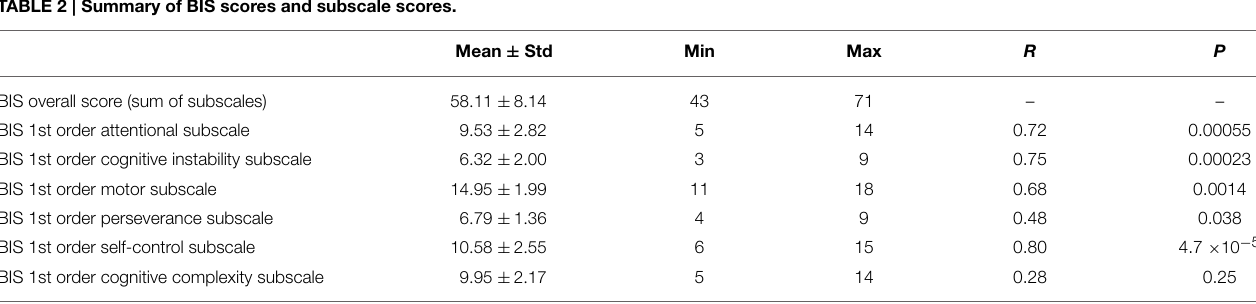
TABLE 2 | Summary of BIS scores and subscale